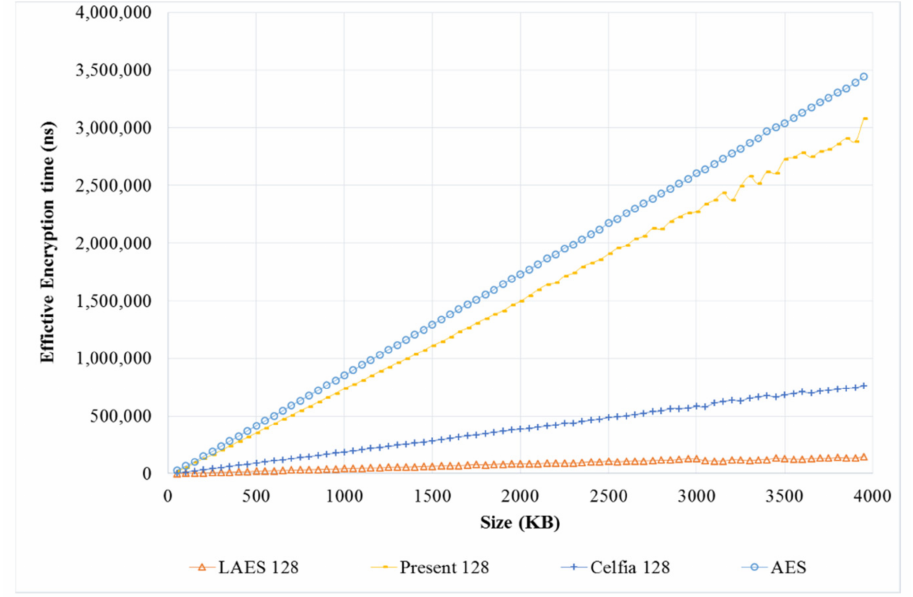
Figure 7. Effective (total) encryption